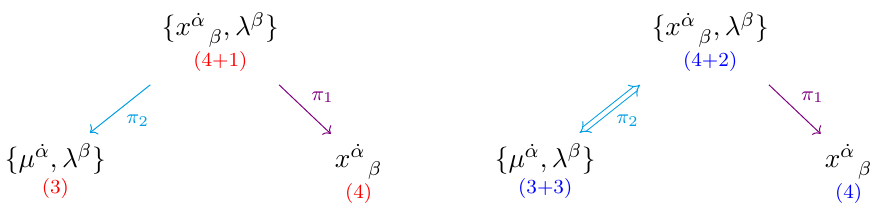
, λ β } ∼ = M C × CP 1 over the β } ∼ = M C . Numbers β